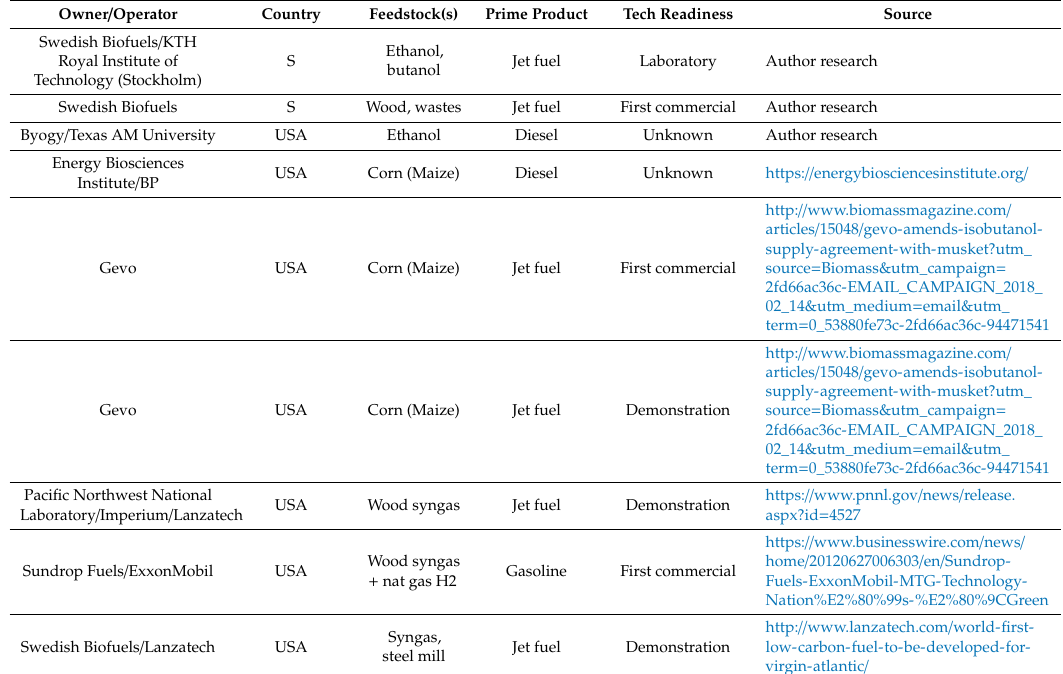
Table 4. Selection of alcohol-to-hydrocarbon